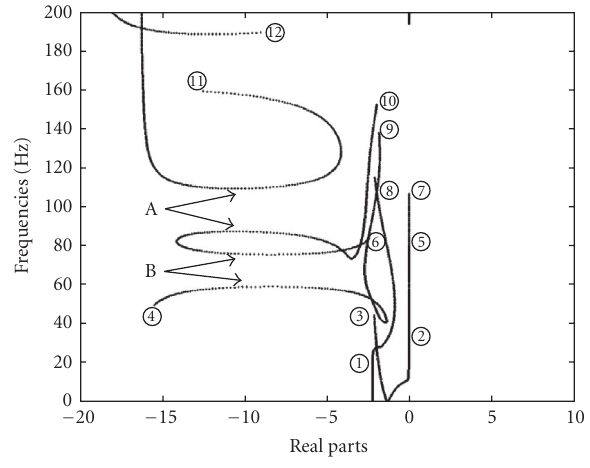
Figure 4: Complex plane diagram for a twenty-eight-bladed rotor with blades of one meter in length.